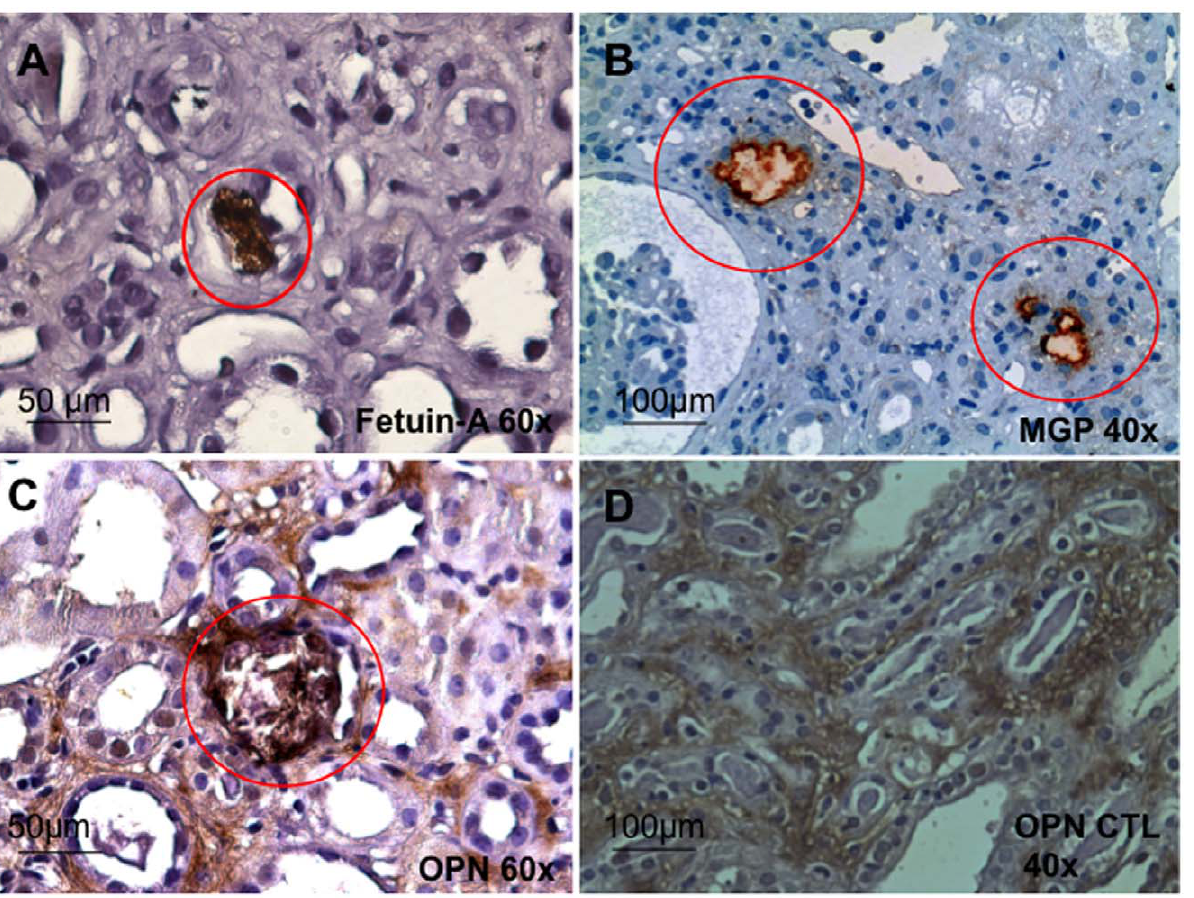
Figure 4. Representative images of Fetuin A (A), MGP (B) and OPN (C) expression are shown (red circle). The expression of the antigens is specifically localized in the vicinity of calcified plaques in patients with calcification. A representative control image is shown for Osteopontin (D). Original magnification: (Fetuin a and MGP x40; OPN x40 and x60).